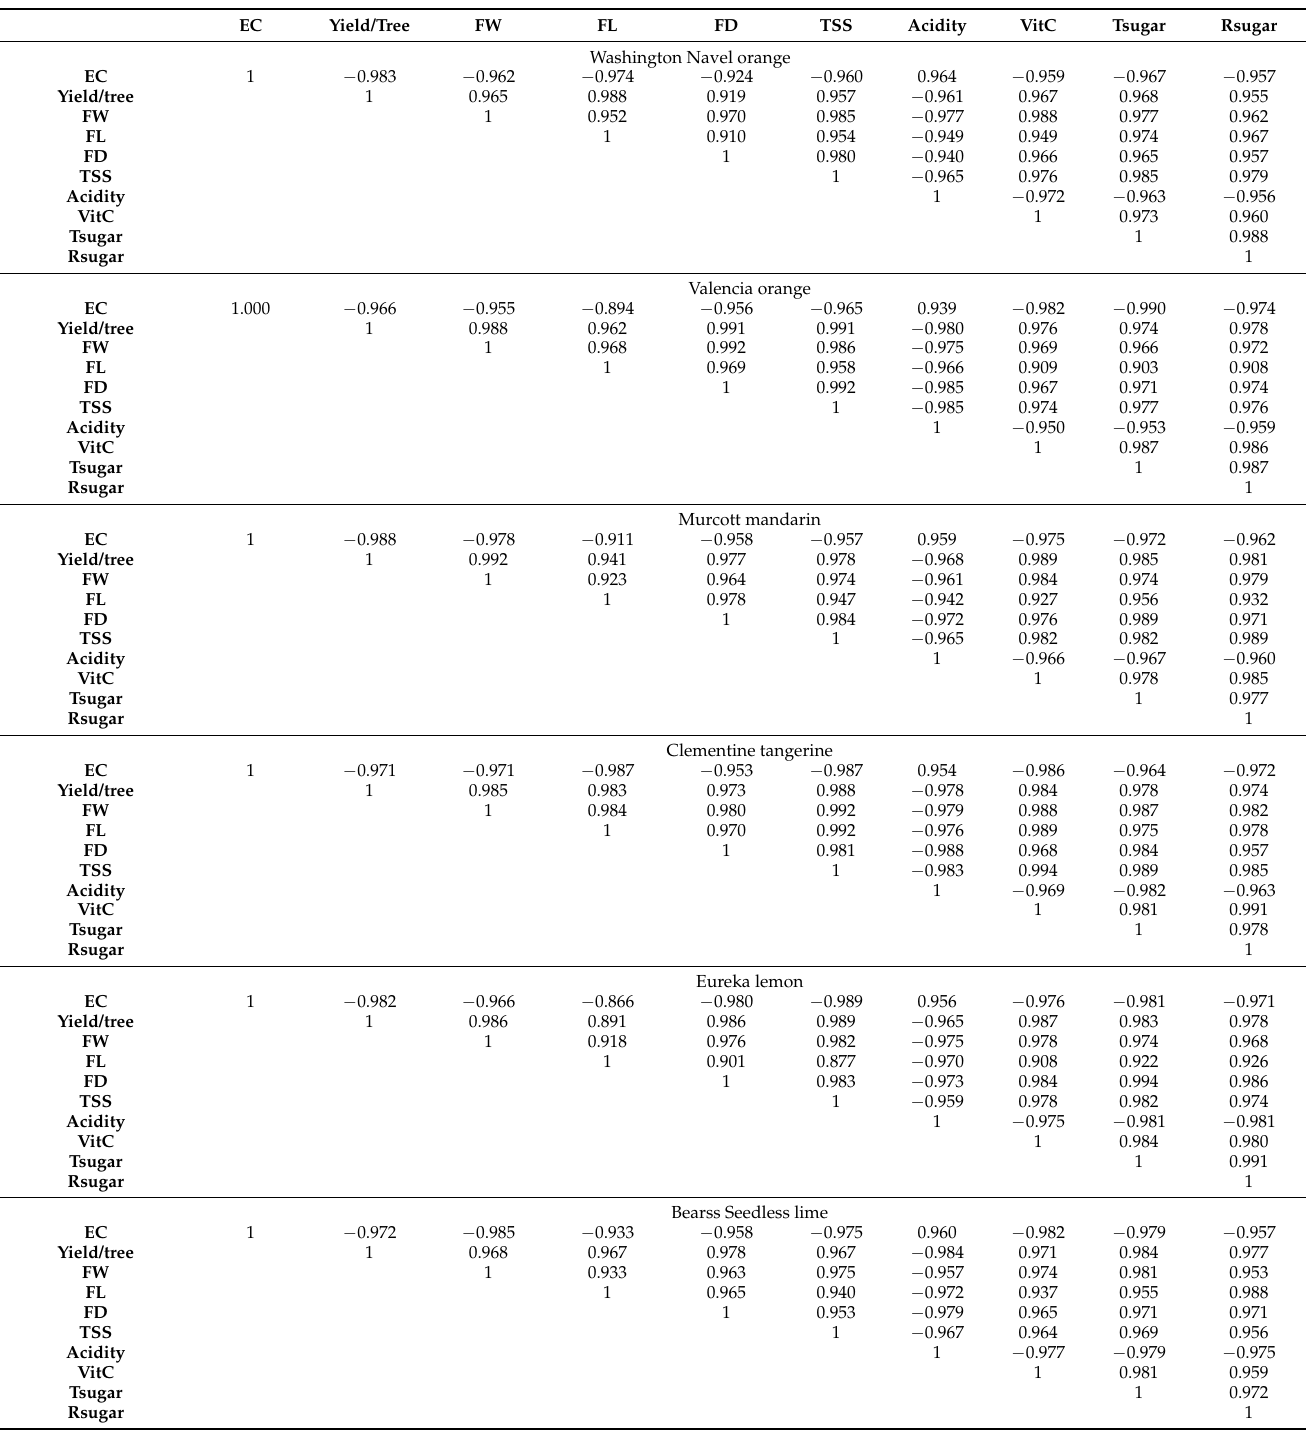
Table 4. Correlation coefficients describing the correlations among the yield/tree, fruit weight (FW), fruit length (FL), and fruit diameter (FD) and chemical attributes for six cultivars of fresh citrus